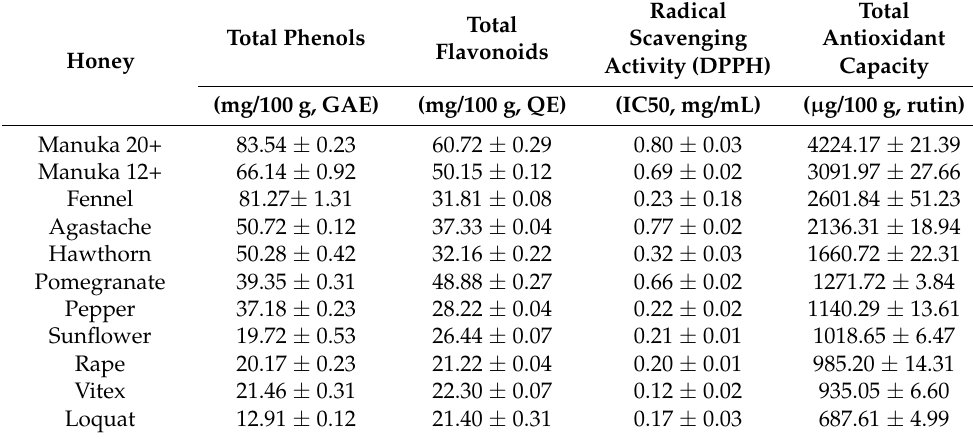
Table 5. The antioxidant activity, total phenols, and total flavonoids content of tested honeys.